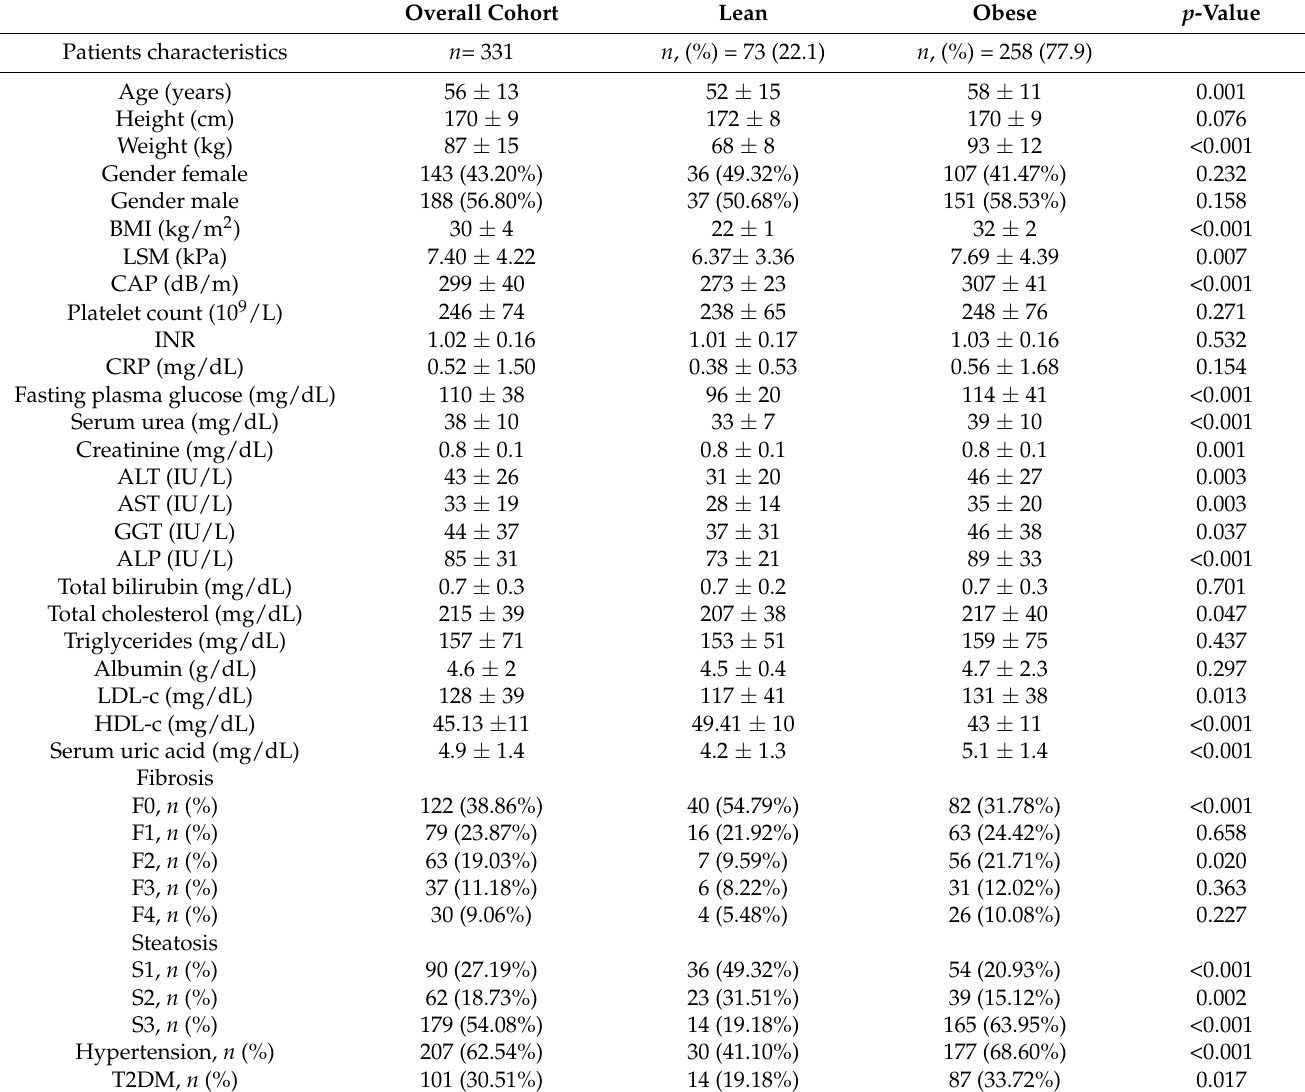
Table 1. Baseline characteristics of